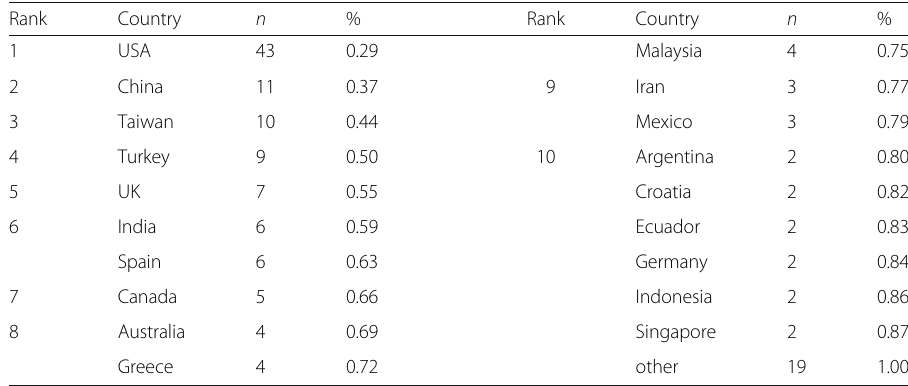
Table 4 Distribution of articles by country and cumulative percentages ( n = 146)